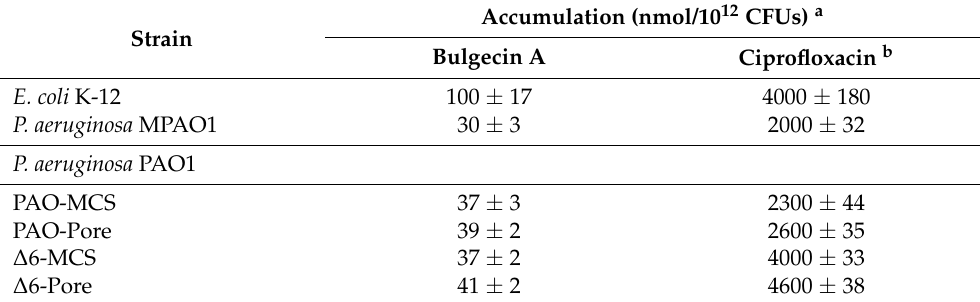
Table A2. Accumulation of bulgecin A in the wild-type E. coli K-12 and P. aeruginosa MPAO1, and the mutant P. aeruginosa